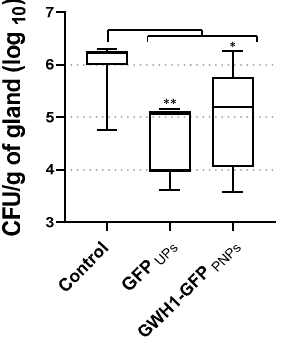
Figure 7. Antimicrobial effect of GFP and GWH1-GFP (PNPs) over S. aureus- infected mammary glands in vivo. Mammary glands were harvested and processed 8 h after the simultaneous administration of 100 CFU of S. aureus and 60 µmol/L of protein, respectively. Sodium bicarbonate buffer (166 mmol/L NaHCO 3 , 333 mmol/L NaCl) was used as control. The middle bars indicate median values for each group of glands (at least 6 glands) whereas the boxes specify quartiles Q1-Q3. The experiment was performed in triplicates. Significant results are shown as * p ≤ 0.05, ** p ≤ 0.01, one-way analysis of variance (ANOVA), followed by Tukey’s multiple comparisons test.